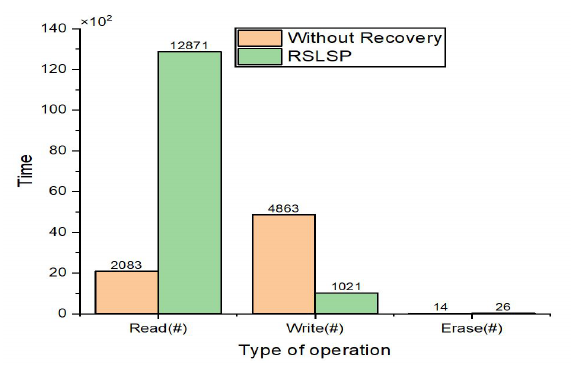
Figure 12. Results (time): pattern C.